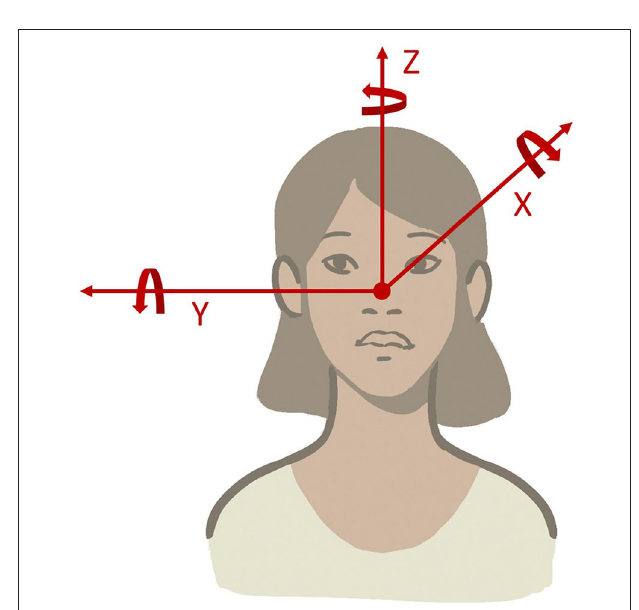
FIGURE 3 | Schematic overview of head rotations along three axes (X, Y, and Z). Axes are defined relative to the person, not to